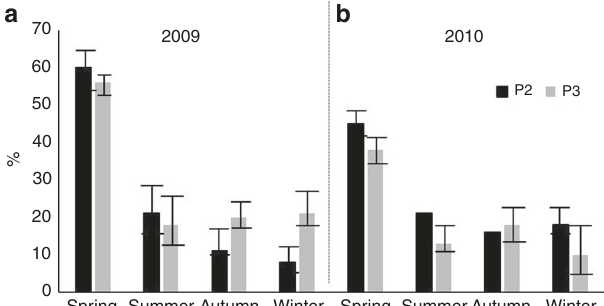
Fig. 3 Coccolithophore included within faecal pellets. Coccolithophore aggregates included within faecal pellets, expressed as seasonal contribution (%) of the total coccolithophore assemblage for each year a 2009 and b 2010 at P2 and P3. Error bars indicate 1 standard